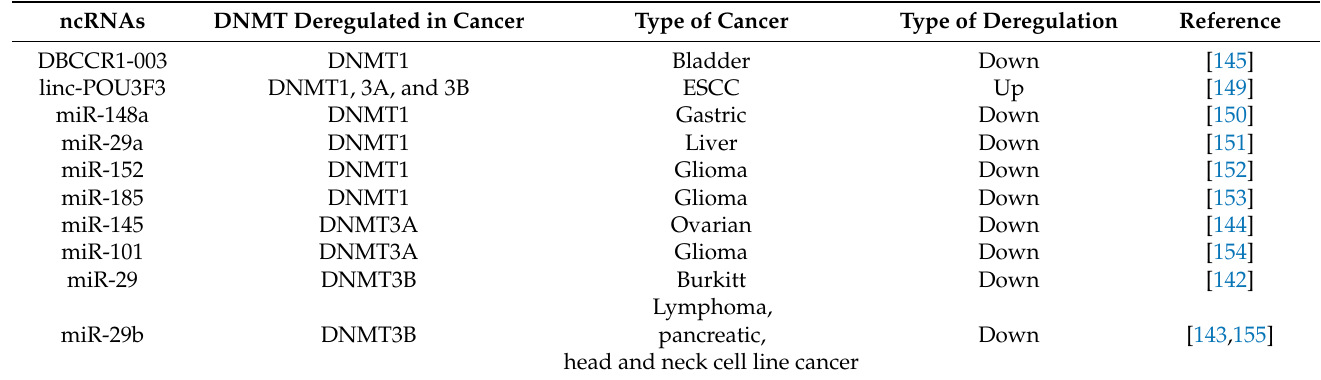
Table 4. Studies of DNA methyltransferases (DNMTs) and non-coding RNAs in